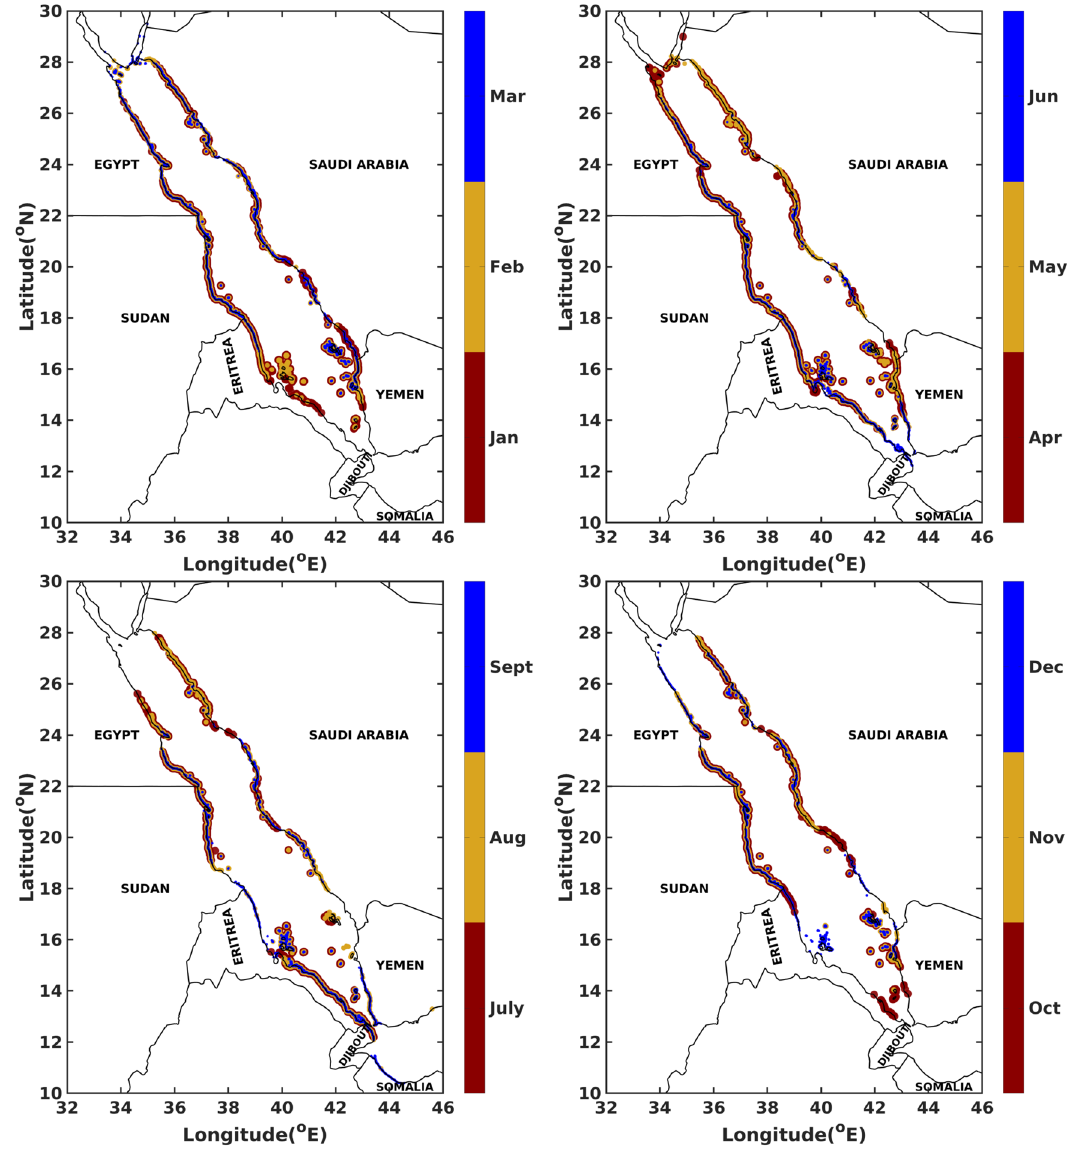
Figure 6. Superposition maps of the positions of oil particles beaching the shorelines in the whole Red Sea for all twelve (12) months, twenty (20) days after the commencement of the spill. The figures were created on Matlab-r2020b (https:// matlab- r2020b. softw are. infor mer.